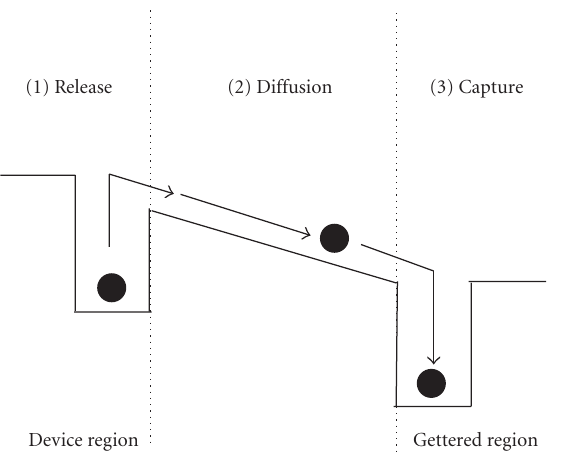
Figure 5: Sketch of the basic principle of di ff usion-induced gettering of impurities.